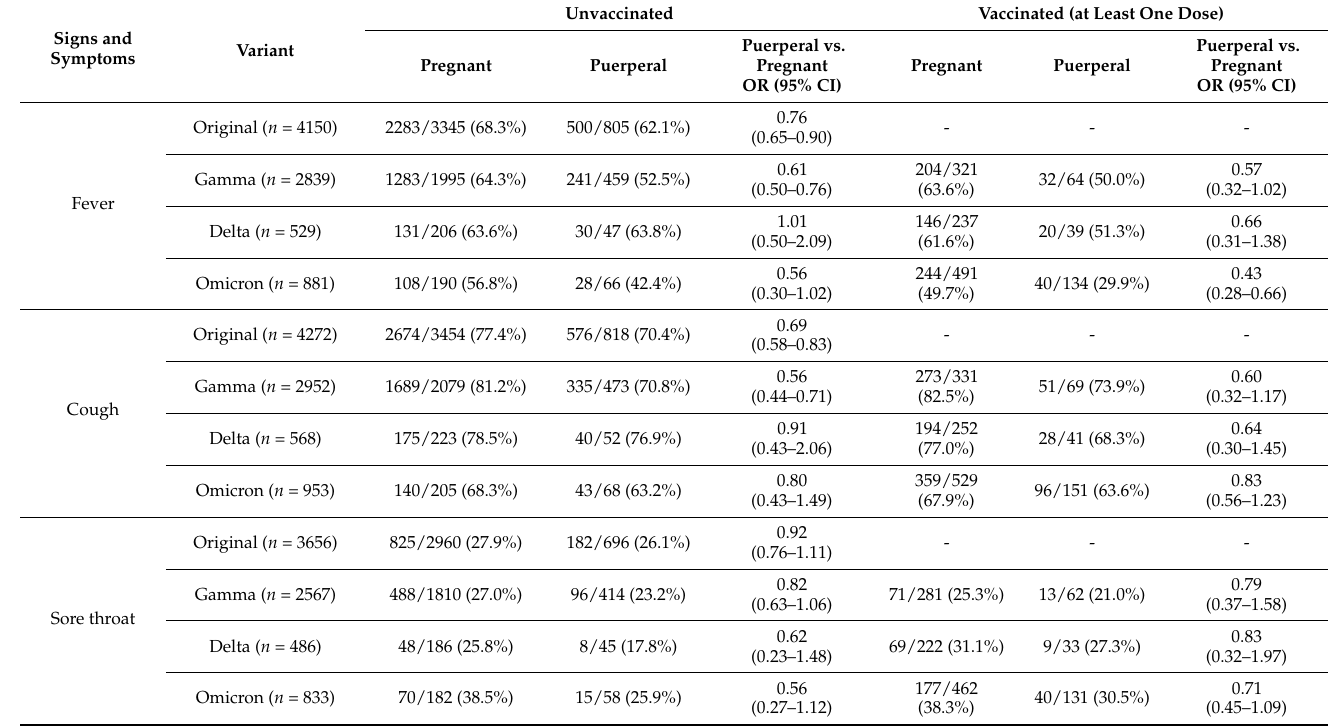
Table 2. Signs and symptoms of COVID-19 in pregnant and postpartum